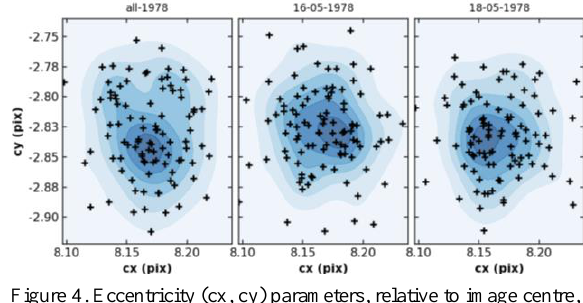
Figure 4. Eccentricity (cx, cy) parameters, relative to image centre, from 100 independent bootstrap samples of 70% of tie points using either, all photos, 16-May or 18-May flights. Variations remain small (0.15-0.2 pixel). With 100% of tie points (67 073 points) the parameters equal to cx= 8.24 and cy= -2.75.